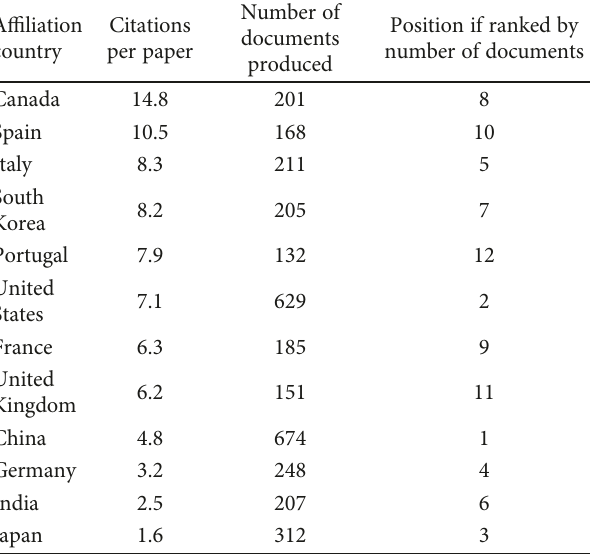
Table 13: Citations per paper and number of documents by country (ranked by citations per paper) for the same search term, 2010 –